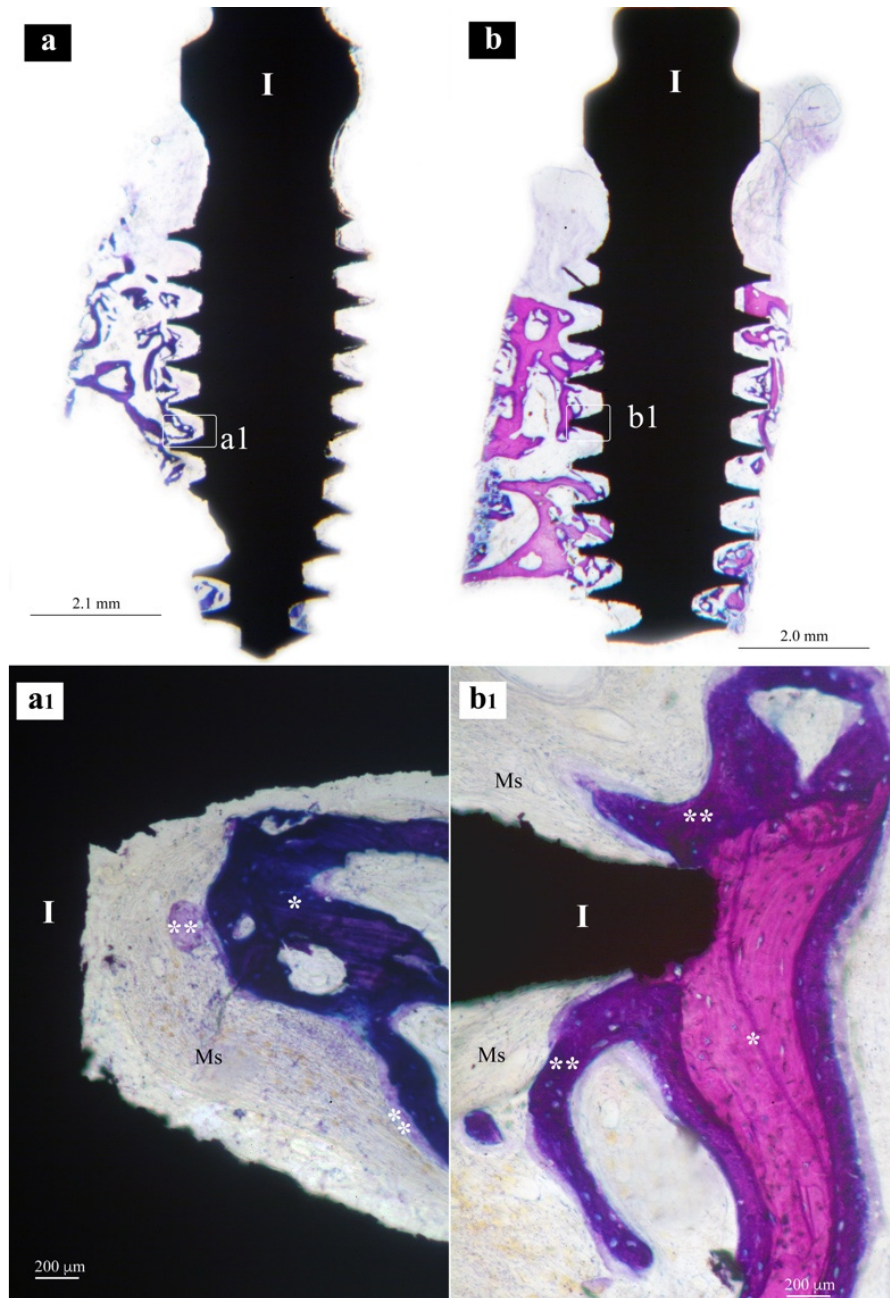
Figure 1. Central sections of two implants of the MAC group after 4 weeks of healing. In ( a , b ), original magnifications (×12), the implant bodies (I) appear to be partially surrounded by bone tissue in the threaded regions. In ( a1 , b1 ), original magnifications (×200), implant threads (I) appear to be in an early phase of osseointegration. Ms, marrow spaces; *, native bone; **, newly formed bone.